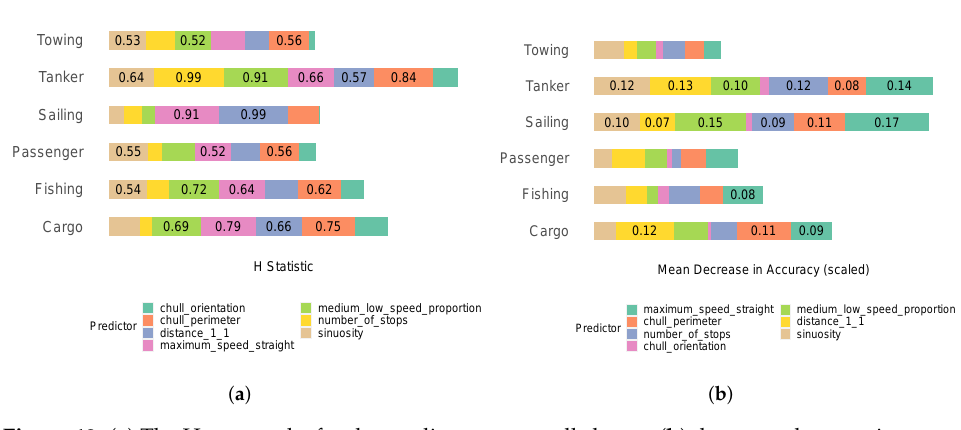
Figure 12. ( a ) The H test results for the predictors across all classes; ( b ) the mean decrease in accuracy (MDA) values for the predictors across all classes.